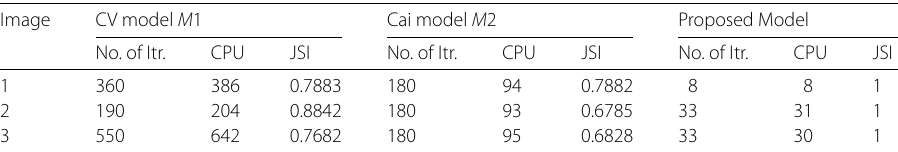
Table 1 Quantitative comparison of the proposed model with CV vector valued [7] ( M 1) and Cai model [14] ( M 2). The solution method used for PDE is Additive Operator Splitting (AOS). Size of each image used here is (256 × 256) Image CV model M 1 Cai model M 2 Proposed Model No. of